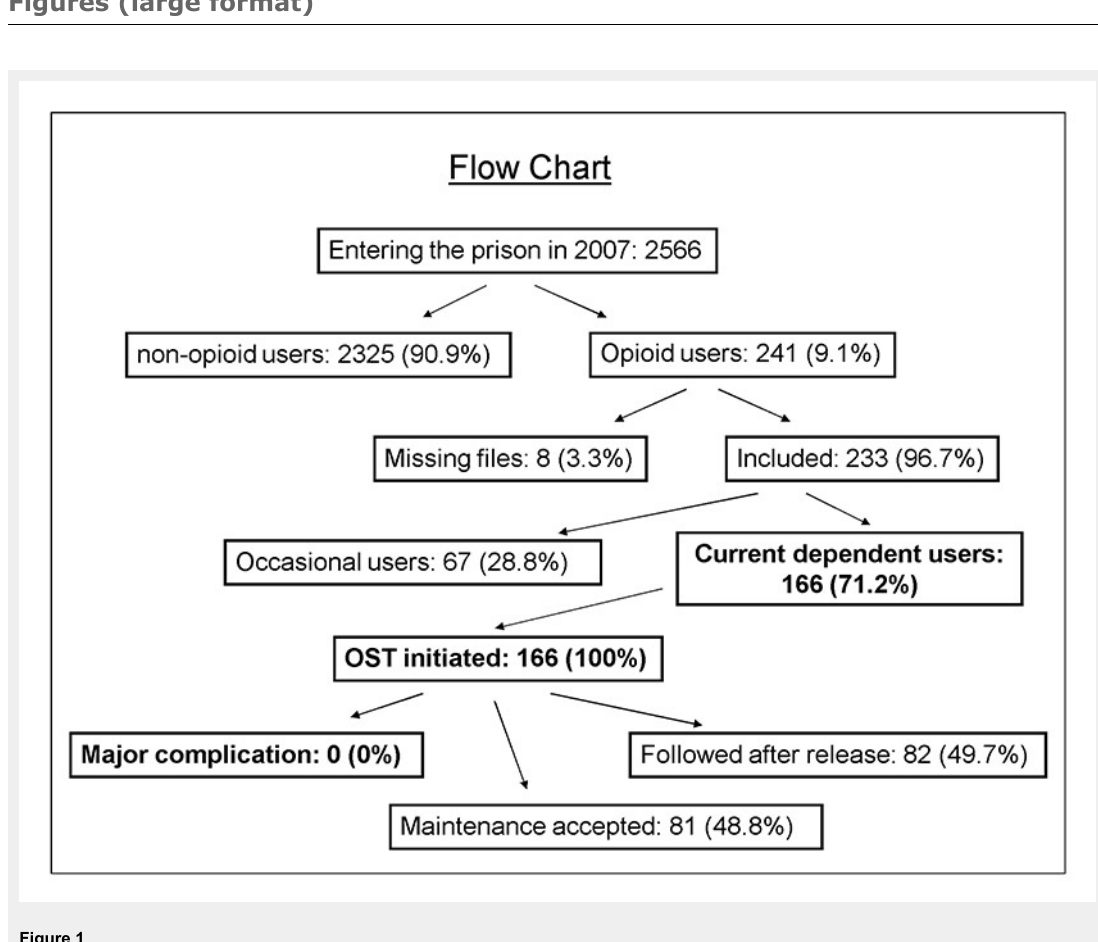
Figure 1 Flow chart of study population within the prison setting in 2007. OST = opioid substitution